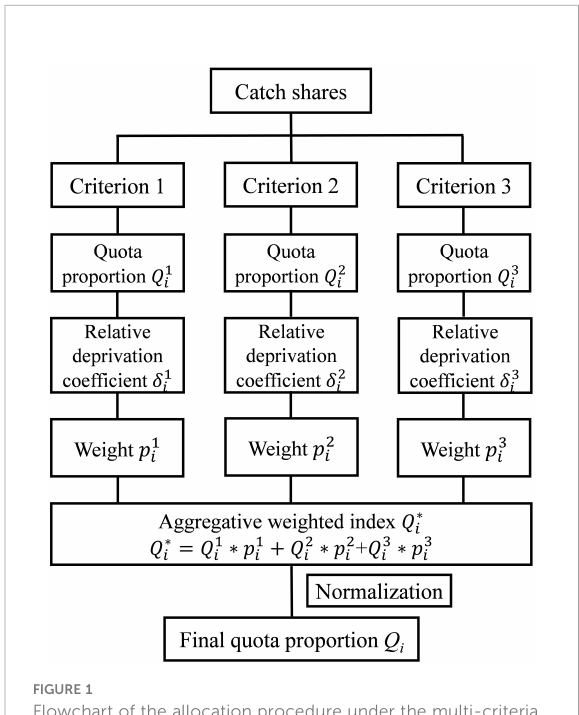
FIGURE 1 Flowchart of the allocation procedure under the multi-criteria comprehensive weighted scheme based on a relative deprivation coef fi